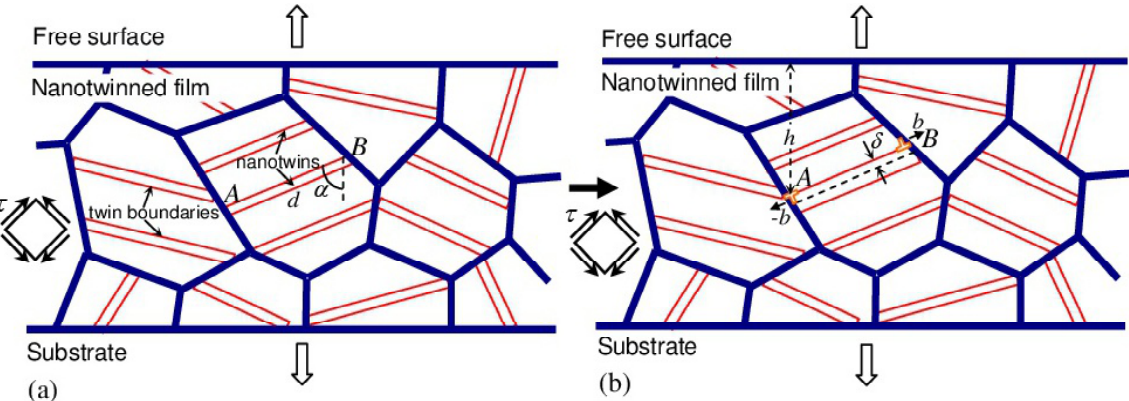
Fig. 1. A model of plastic deformation of an ultrafine-grained film with nanotwinned structure (with ultrafine- grained grains containing high-density ensembles of nanoscale twins). (a) A nanotwinned film specimen is under tensile load. (b) An elementary act of widening of nanotwin occurring through migration of a twin boundary AB in the result of emission of a partial b -dislocation and its motion across the grain over twin boundary AB